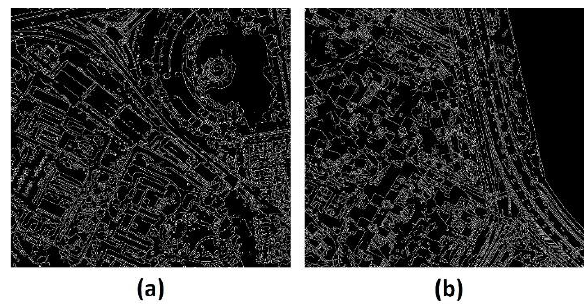
Figure 6. Edge maps (the white pixels denote the edges and the black background is related to non-edges pixels): (a) San Francisco dataset, (b) NY dataset